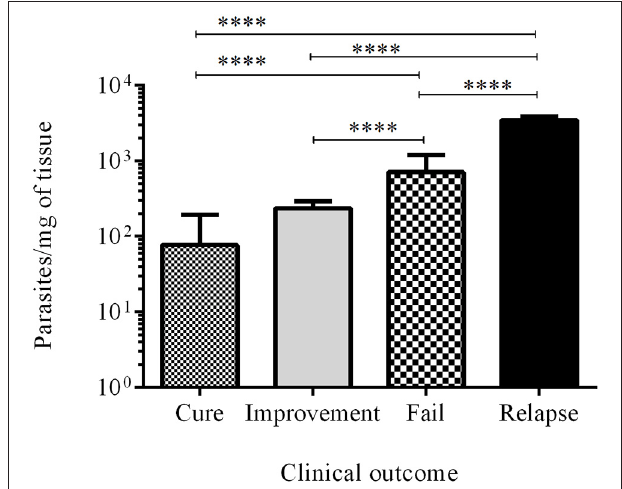
FIGURE 5 | Parasite load . Bars represent the mean value ± SD of the number of parasites per mg of tissue in cured hamsters (white bar), improvement (gray bar), failure (square bar), and relapse (black bar). **** p <